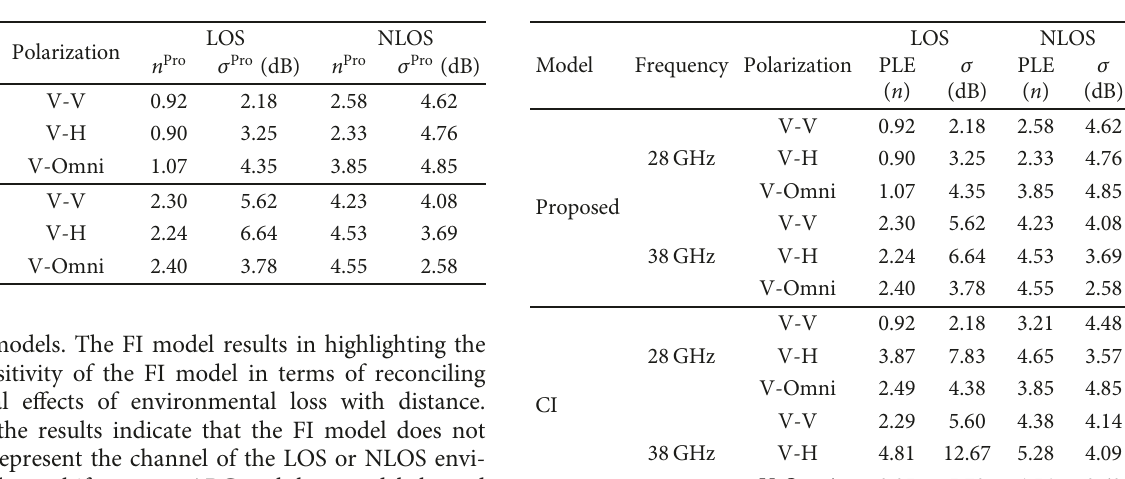
Figure 11: Proposed model for 38 GHz for LOS and NLOS (a) V-V, (b) V-H, and (c) V-Omni antenna polarization. Table 5: Proposed model parameters for LOS and NLOS, at 28 GHz Table 6: Comparison between proposed and CI model ’ s parameters and 38GHz. for LOS and NLOS at 28 GHz and